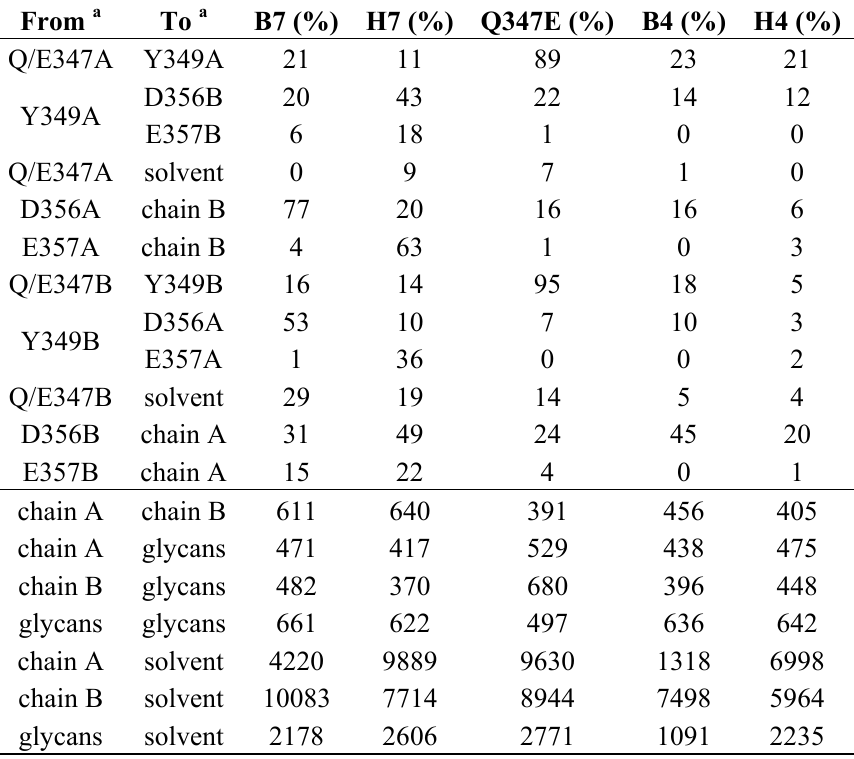
Table 2. Prevalence of hydrogen bonds of selected residues (wild-type, mutant residue and neighboring residues, glycans, solvent) at different protonation states and with/without the hinge